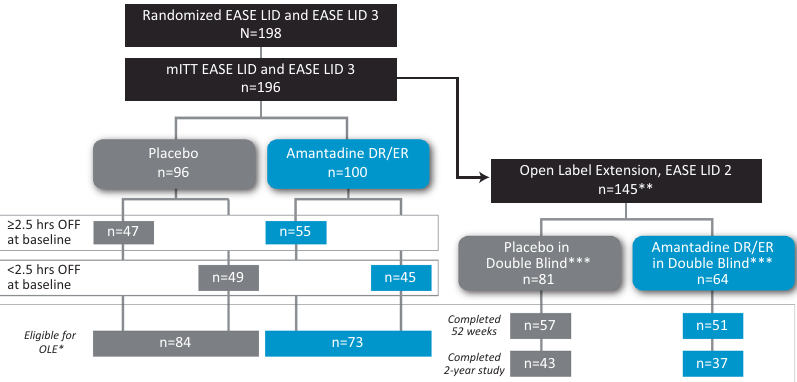
Fig. 1 Patient disposition. *Completed double-blind trial or were active in EASE LID which was stopped early by the sponsor to accelerate data submission to the US Food and Drug Administration 9 . All randomized patients had the opportunity to complete their week 12 trial visit (time of primary ef fi cacy assessment). **An additional 78 patients (not included in the analyses) were enrolled, n = 17 who participated in a phase II dose- fi nding trial and later enrolled in EASE LID 2 after a gap in amantadine-DR/ER therapy, and n = 61 who had DBS and did not participate in double-blind trials 41 . *** Seven participants ( n = 3 who received placebo and n = 4 who received amantadine-DR/ER in double- blind pivotal trials experienced a gap in treatment before entering the open-label trial. For purposes of these analyses we have included them with their original double-blind treatment